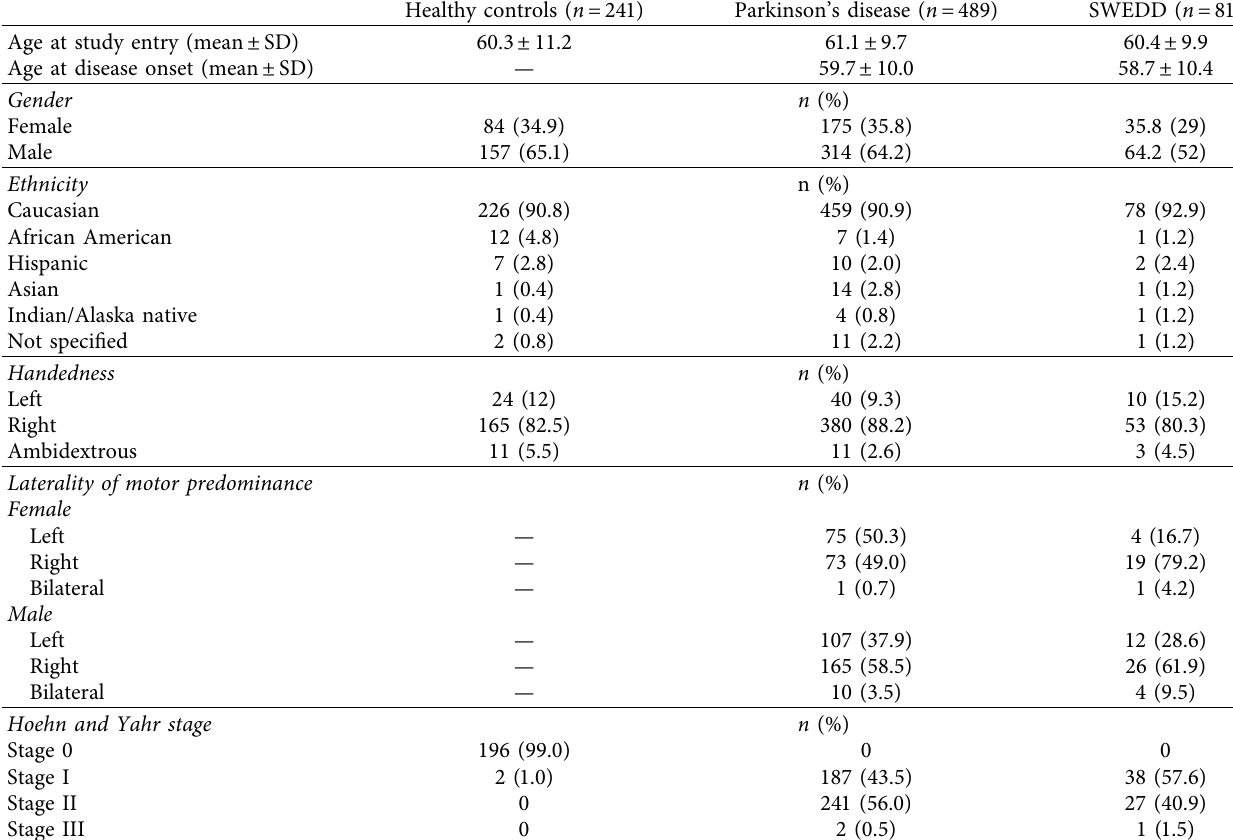
Table 1: Subject